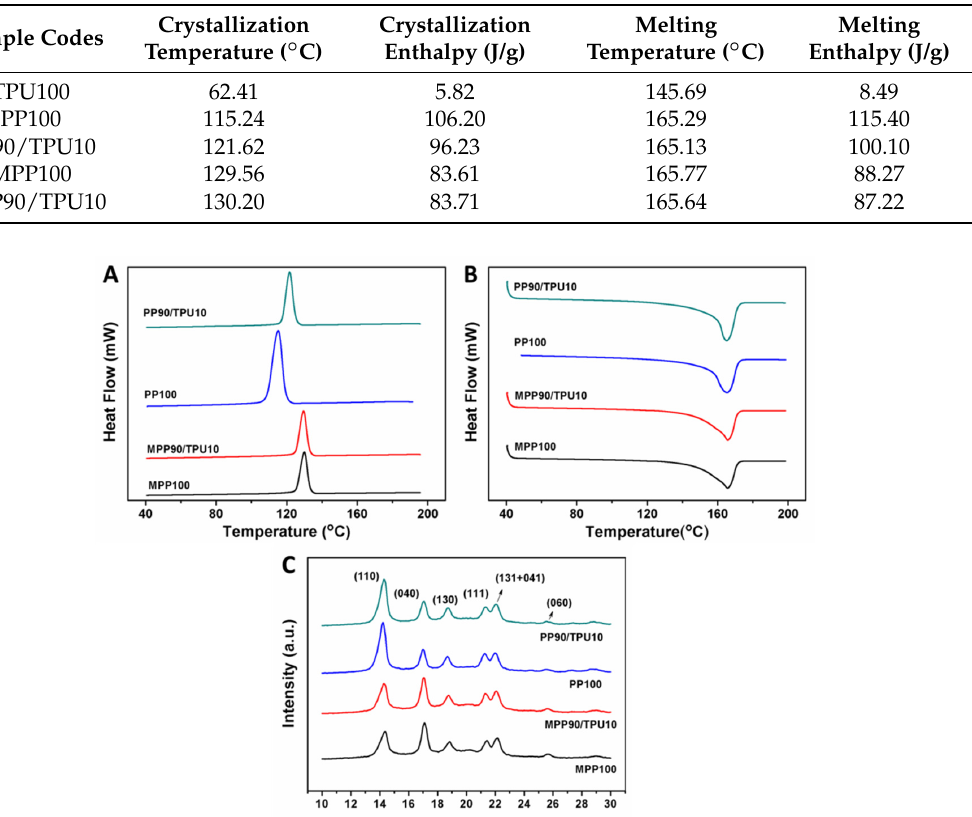
Figure 3. Melting and crystalline behavior of PP/TPU and MPP/TPU blends: ( A ) heating curve, ( B ) cooling curve, and ( C ) X ‐ ray Diffraction (XRD) pattern.